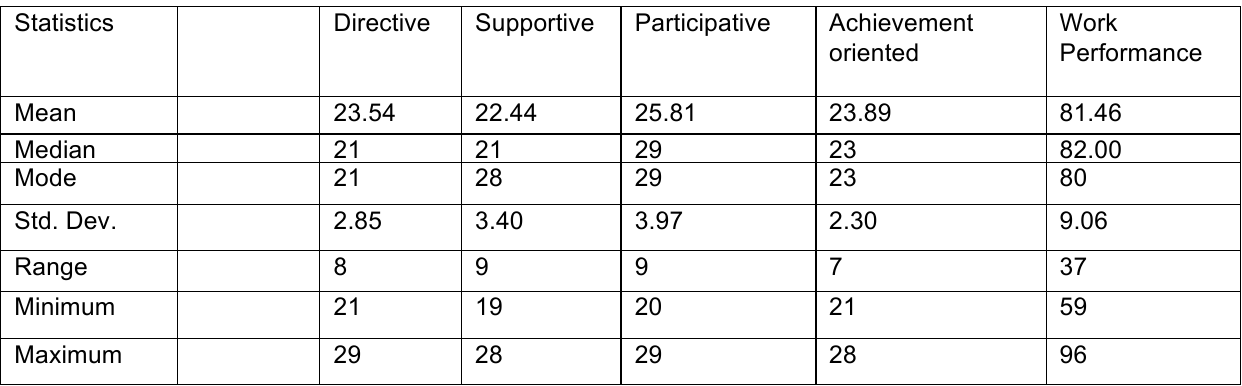
Table 2. Descriptive Statistics for independent and dependent variables ( N